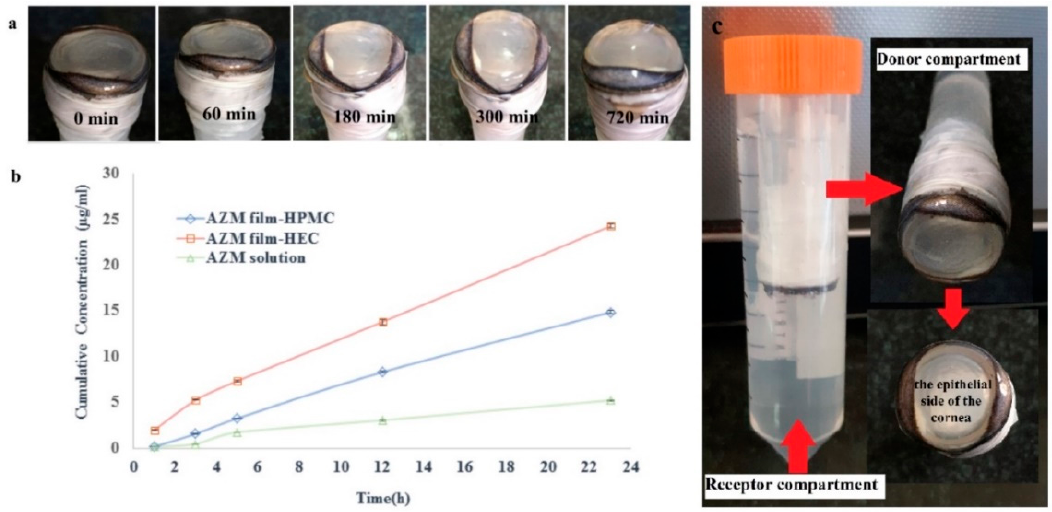
Figure 10. Ex vivo evaluation of AZM